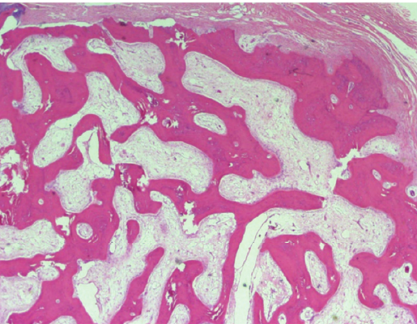
Figure 16: Medium-power view of bony spicules with intermixed cartilage and intraosseous fibrous tissue (hematoxylin-eosin stain; magnification × 10). Osteoblastic activity is prominent; osteoclastic activity is also appreciated.